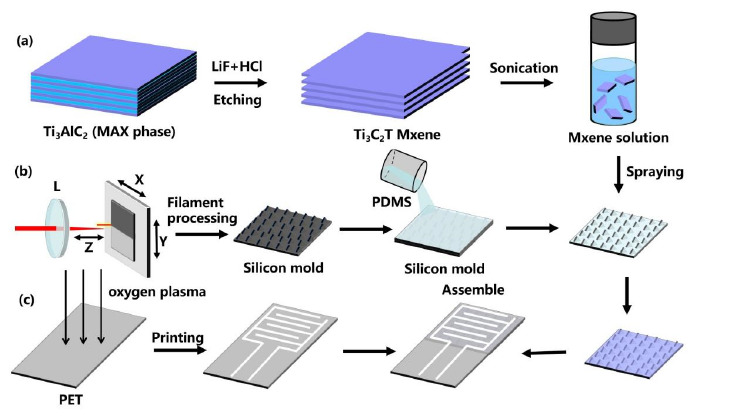
Figure 1. ( a ) Preparation of Ti 3 C 2 T x MXene. ( b ) Preparation of Micro-Patterned MXene/PDMS conductive film. ( c ) Assembly of the MXene-based piezoresistive